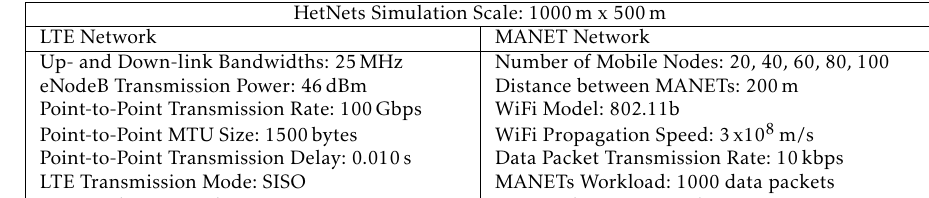
Table 2. Simulation Parameters